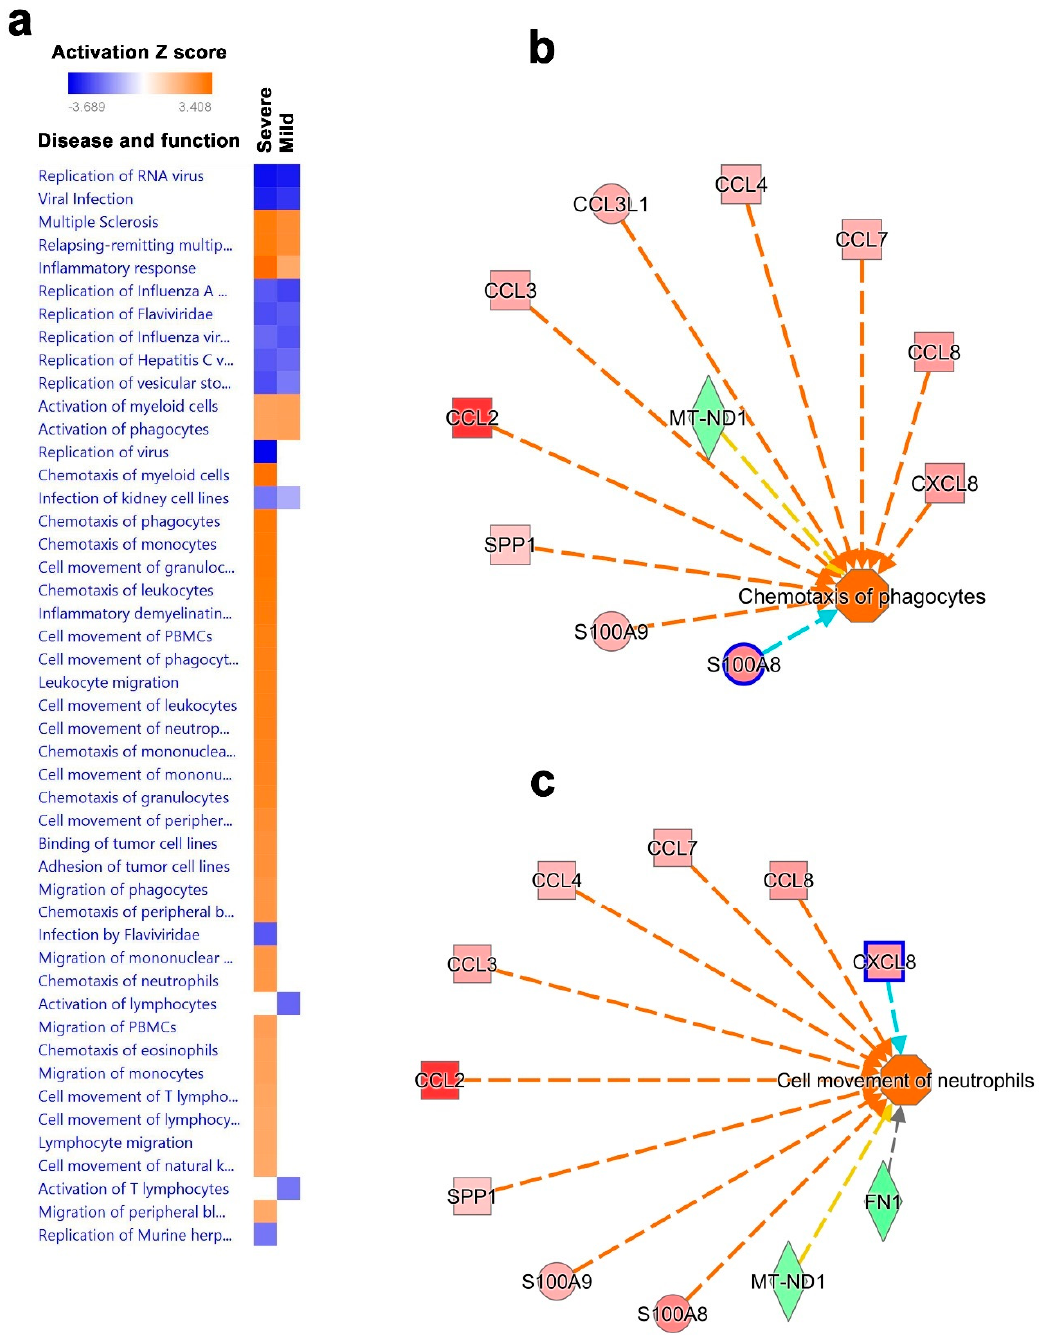
Figure 8. Disease and functional analysis of differentially expressed genes in BAL from patients with mild and severe COVID-19. ( a ) Heat map depicting the activation states of the indicated disease and function categories in mild- and severe-COVID-19 BAL cells. Illustration of chemotaxis of phagocytes ( b ) and cell movement of neutrophils ( c ) in patients with severe COVID-19 based on IPA analysis.